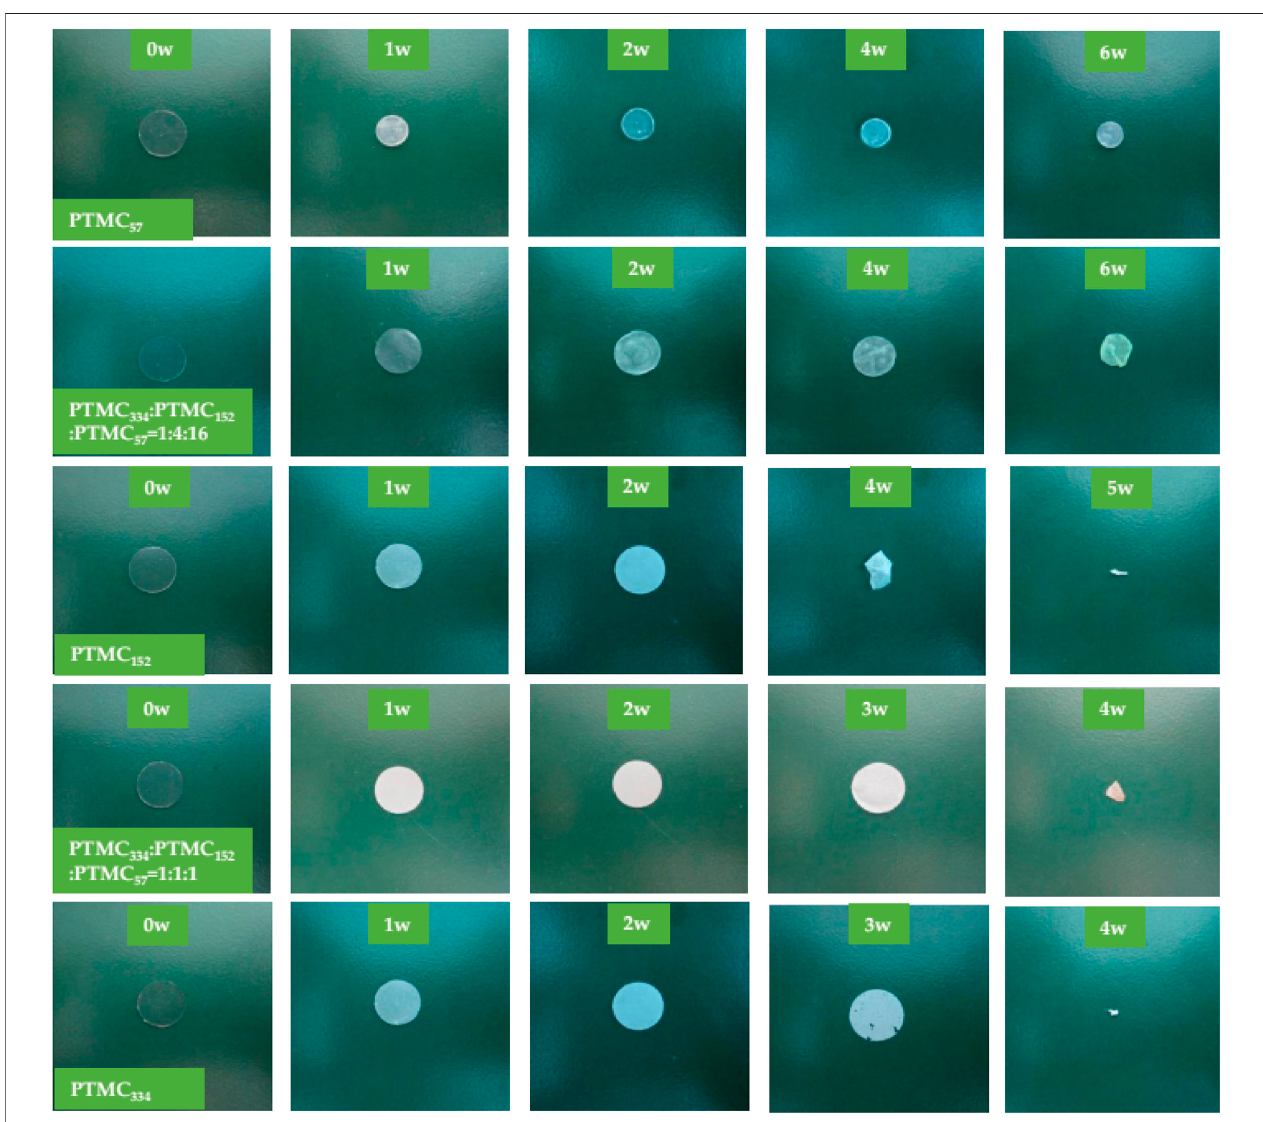
FIGURE 2 | The macroscopic observation of the PTMC fi lms PTMC fi lms and ternary self-blending fi lms at different times in 37 ° C lipase.